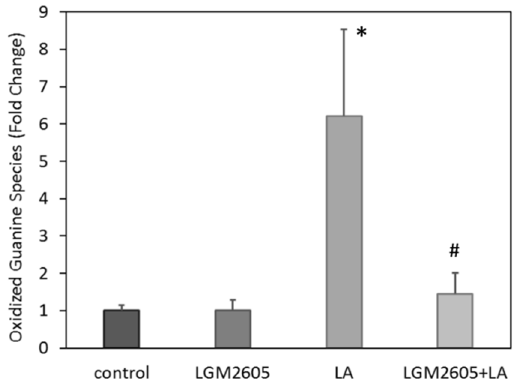
Figure 9. Detection of oxidized guanine species in PLF. LA treatment significantly increased relative concentrations of oxidized guanine species relative to saline control, * p = 0.023. LGM2605 + LA treatment decreased relative concentrations of oxidized guanine species back to control levels, # p = 0.022. Following two-way ANOVA, data were analyzed via Tukey post-hoc test. Data are reported as the mean fold change ± SEM in the levels of oxidized guanine species from their respective, non-LA-exposed controls, in PLF.